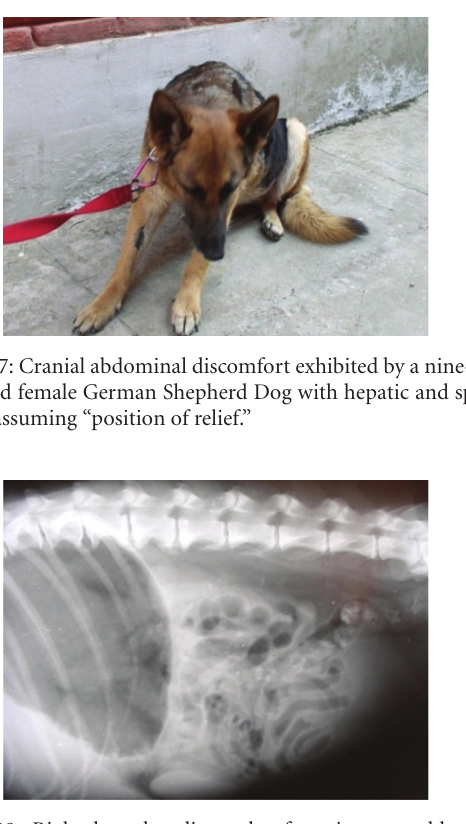
Figure 26: Longitudinal sonogram (2D) of liver of two and half-year-old, intact female Pointer dog showing cholecystitis as echogenic thickened GB wall and mineralization in the neck of gall bladder with acoustic shadowing along with hyperechoic parenchyma.